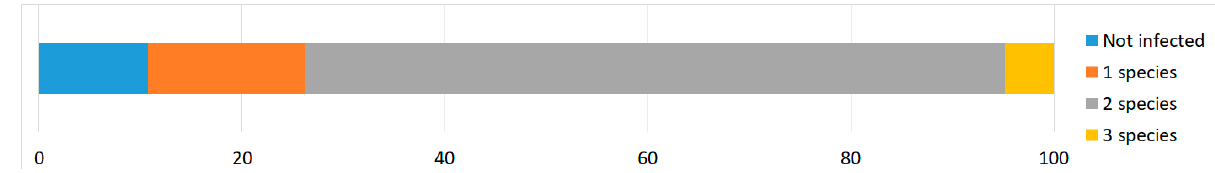
Figure 3. Distribution of the number of Sarcocystis spp. identified in the examined samples of